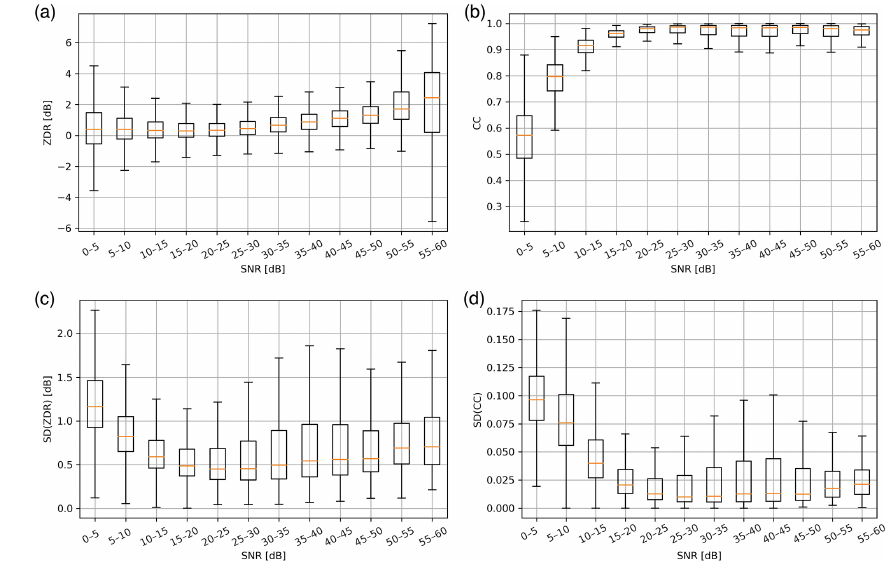
Figure 8. The boxplot of SNR vs. polarimetric features of MET: (a) ZDR, (b) CC, (c) SD(ZDR), and (d) SD(CC).